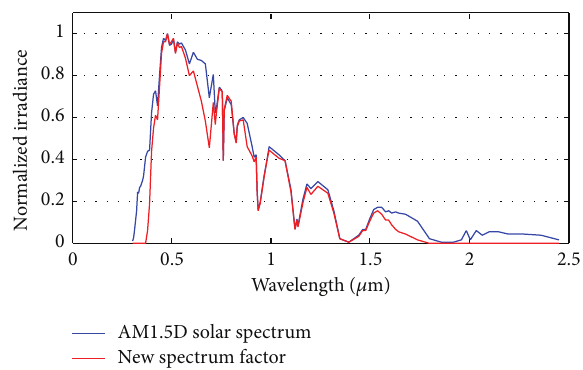
Figure 6: The introduced spectrum factor for consideration of the solar cell response.